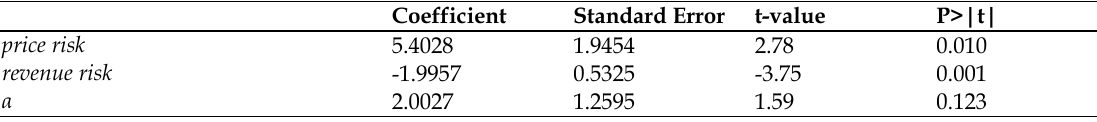
Table 2. Results of multiple regressions with number of bidders as dependent variable Coefficient Standard Error